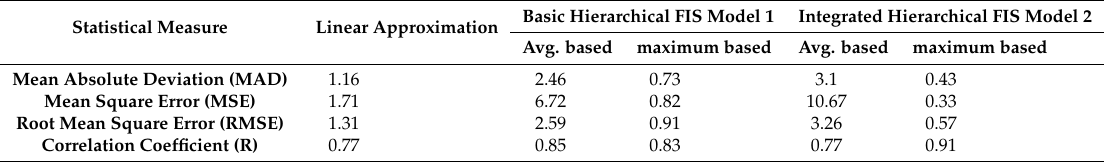
Table 6. Statistical comparison of selected risk index approximation